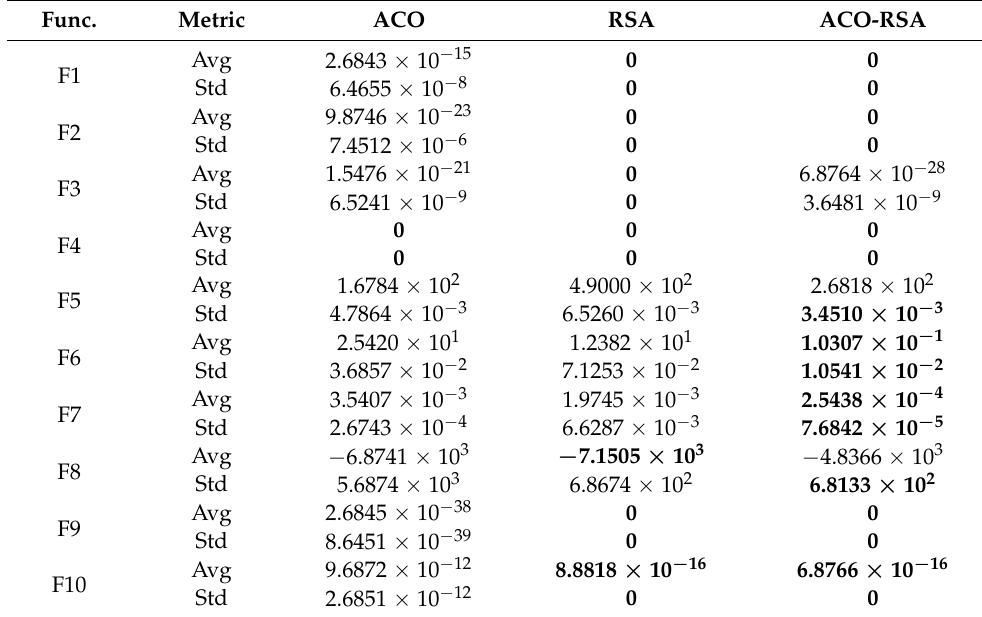
Table 10. Avg and Std results using CEC 2019 test functions.